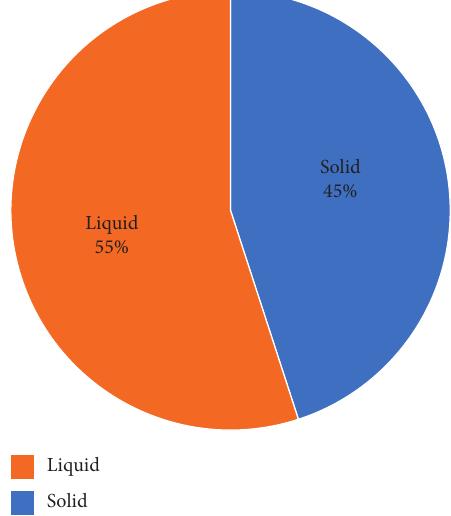
Figure 2: A pie chart showing respondents ( n � 150) preference for liquid and solid dosage forms of herbal antimalarials in the Ningo Prampram district. 55% of the respondents in the Ningo Prampram district indicated that they preferred liquid dosage form of herbal antimalarials, while 45% indicated